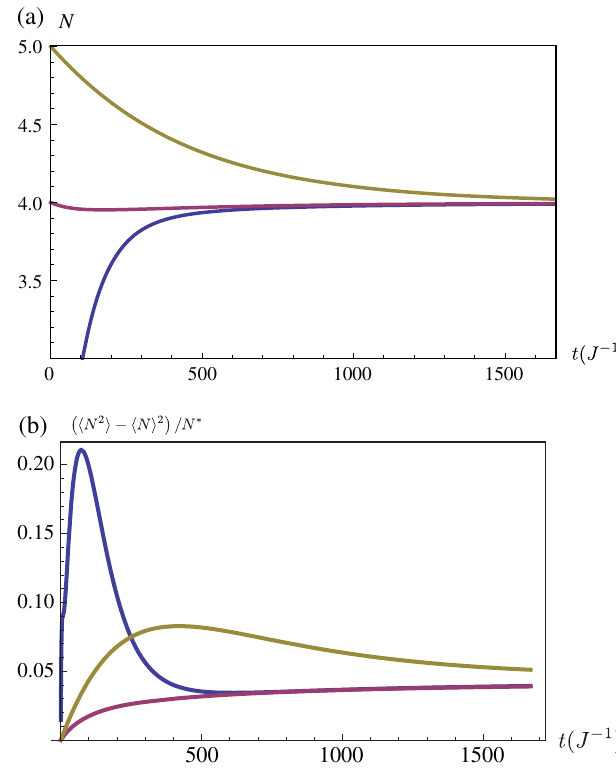
FIG. 3. Commensurability and incompressibility of the sta- tionary state, computed in the refilling rate approximation for a 6 × 4 lattice with periodic boundary conditions, ϕ ¼ 1 = 3 , Γ ≃ 50 , and Γ 0 . 00067 J . (a) The three curves initialize = Γ R P P ¼ the system ’ s density matrix in the empty state N ¼ 0 (blue, bottom curve), the Laughlin state (purple, center curve), and the Laughlin state with a quasiparticle excitation (gold, top curve), and time is evolved by numerically integrating the Lindblad equation (8). In all cases, the system relaxes to a Laughlin state with a negligible density of excitations, as discussed in the text. Identical behavior is observed in all cases studied. (b) Signatures of incompressibility in this system. We plot the average number fluctuations ðh N 2 i − h N i 2 Þ =N (cid:2) for the same parameters and initial conditions, dem- onstrating that number fluctuations are highly suppressed by the combination of the energy gap Δ and the rapid refilling rate Γ The small asymptotic value of ðh N 2 i − h N i 2 Þ =N (cid:2) ∼ 0 . 05 stands in